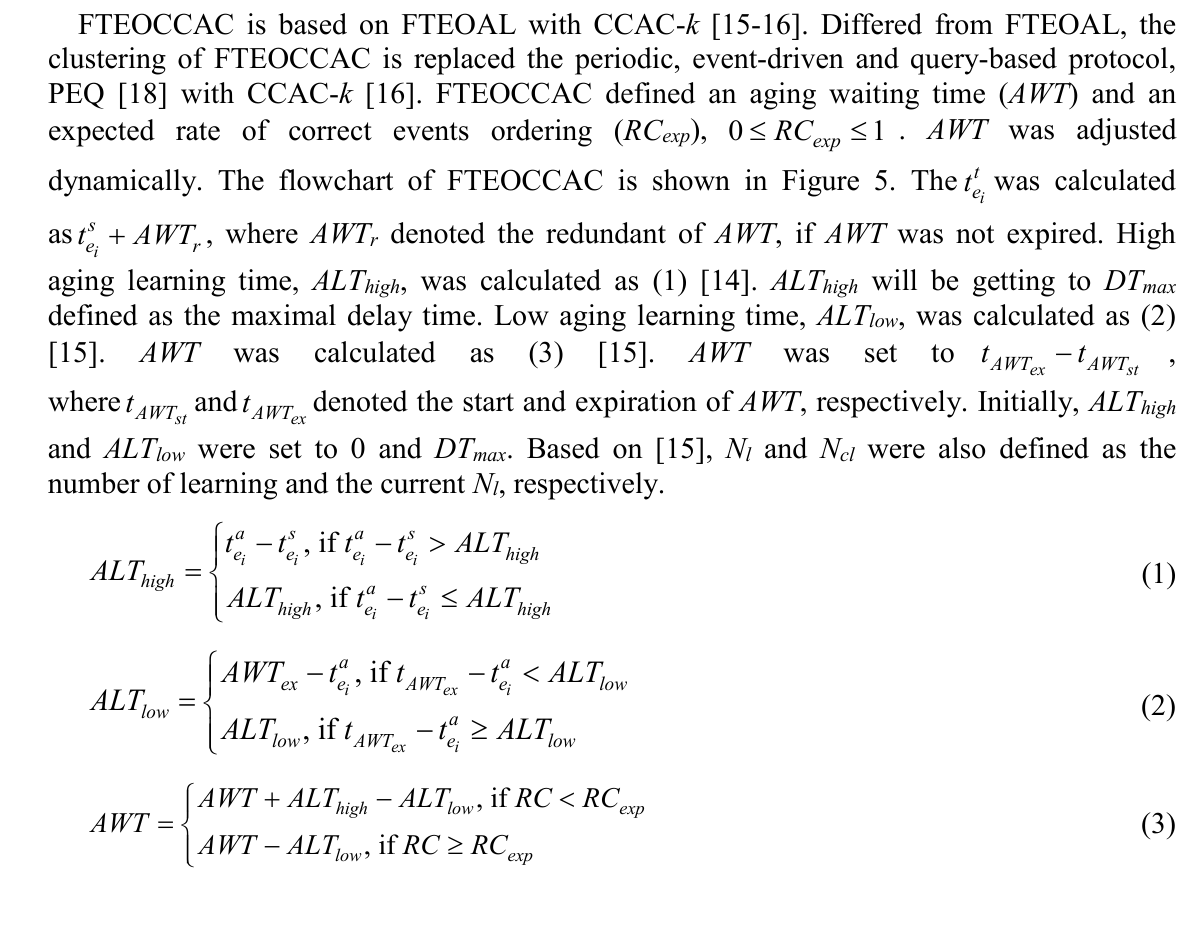
Figure 4. Coverage and connectivity problems